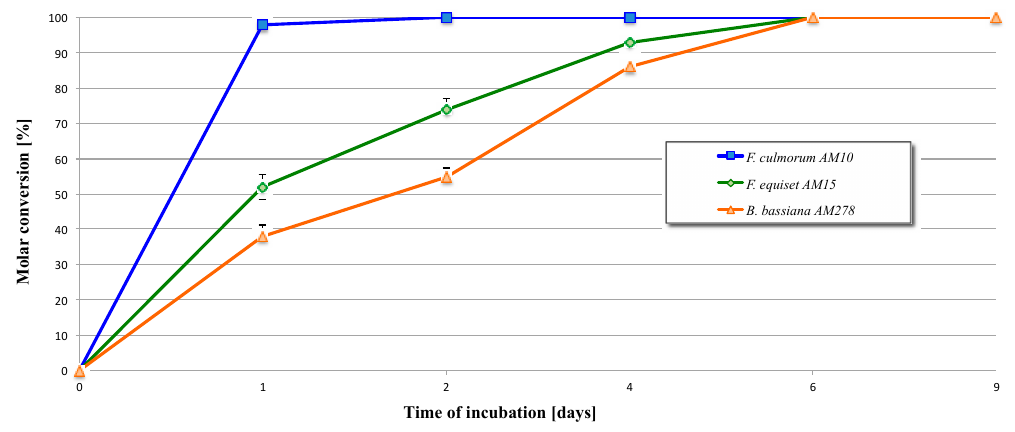
Figure 3. Time course of the transformation of lactone ( 2 ) by selected fungal strains.